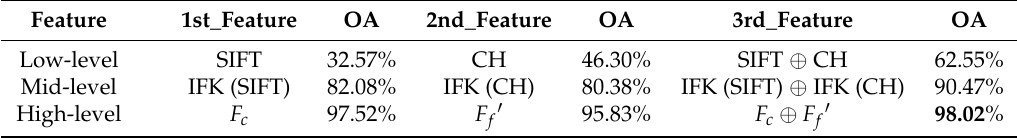
Table 4. Classification accuracies of different features. The best result is in